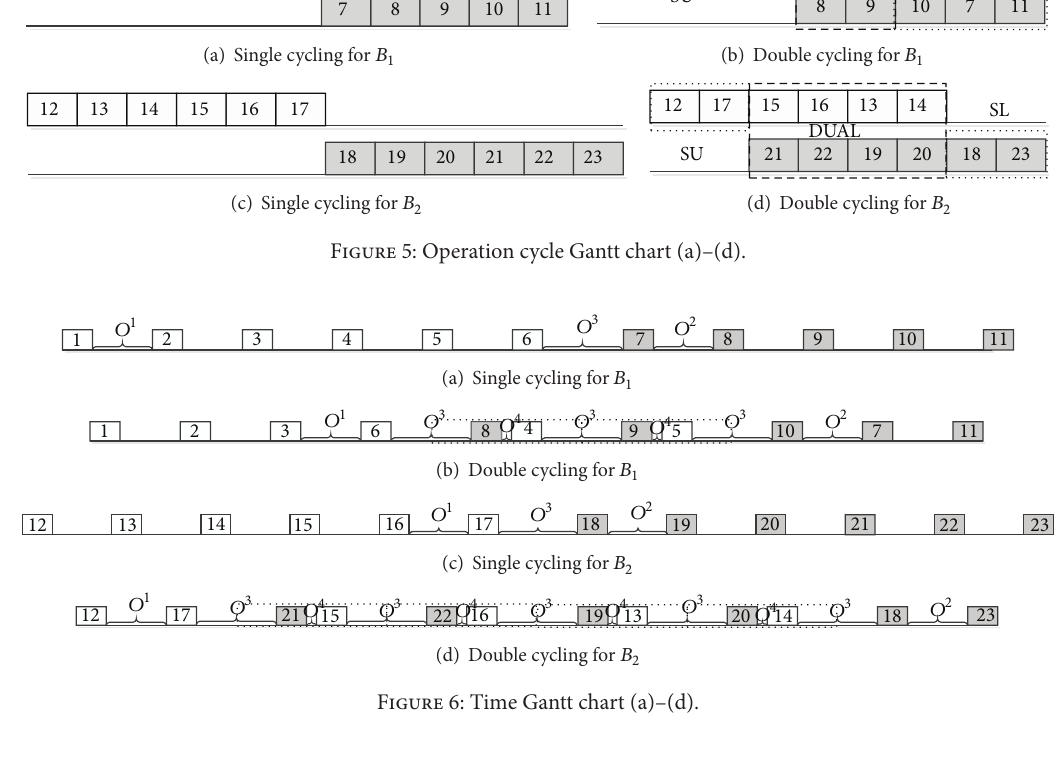
Table 2: Conflicts